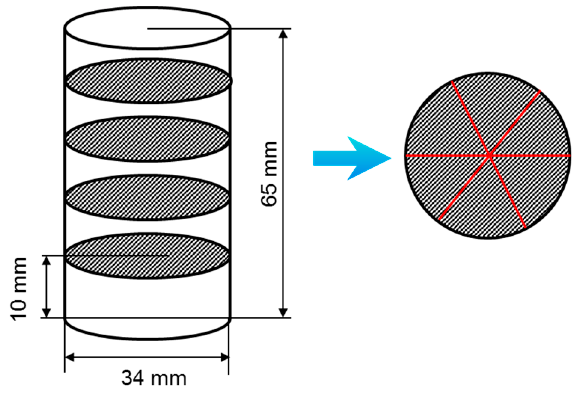
Figure 1. Schematic of the machined samples.